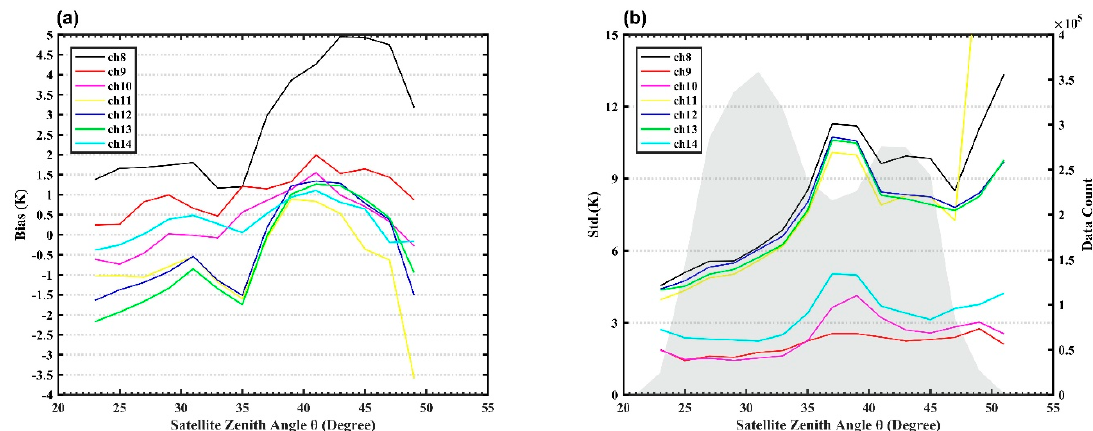
Figure 9. The dependence of ( a ) biases (OMB, unit: K) over the land and ( b ) standard deviations on satellite zenith angle 𝜃 (unit: degree) at 2° intervals for AGRI channels 8–14 over land. Observation counts at 2° intervals are shaded gray in ( b ).